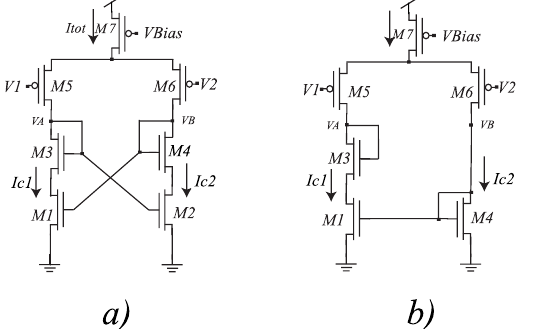
Figure 5. ( a ) Stacking of a PMOS differential pair and the proposed correlator circuit. The behavior of currents Ic 1 and Ic 2 is a combination of the current behavior of the correlator and a differential pair. ( b ) Circuit model of the combined circuit when V2 increases and V1